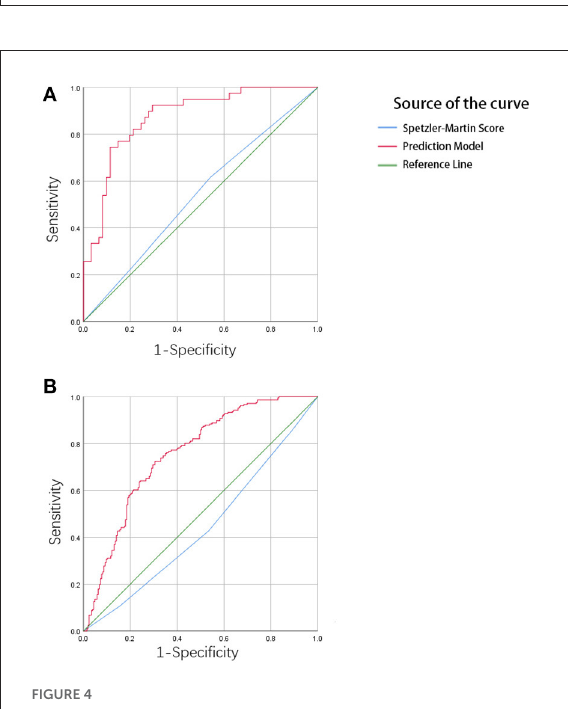
FIGURE4 (A) The result of ROC analysis in the training cohort. The area under the curve (AUC) is 0.873, p < 0.001. (B) The result of ROC analysis in the validation cohort. The area under the curve is 0.754, p < 0.001.